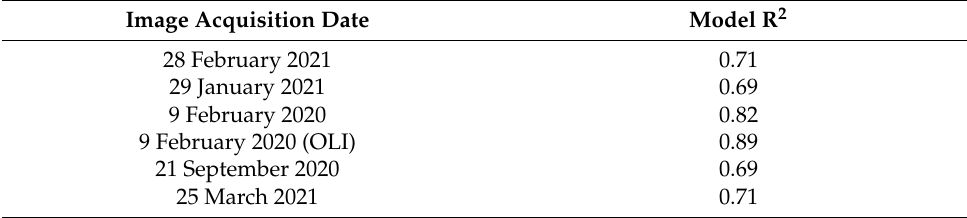
Table 6. GWR model statistics.